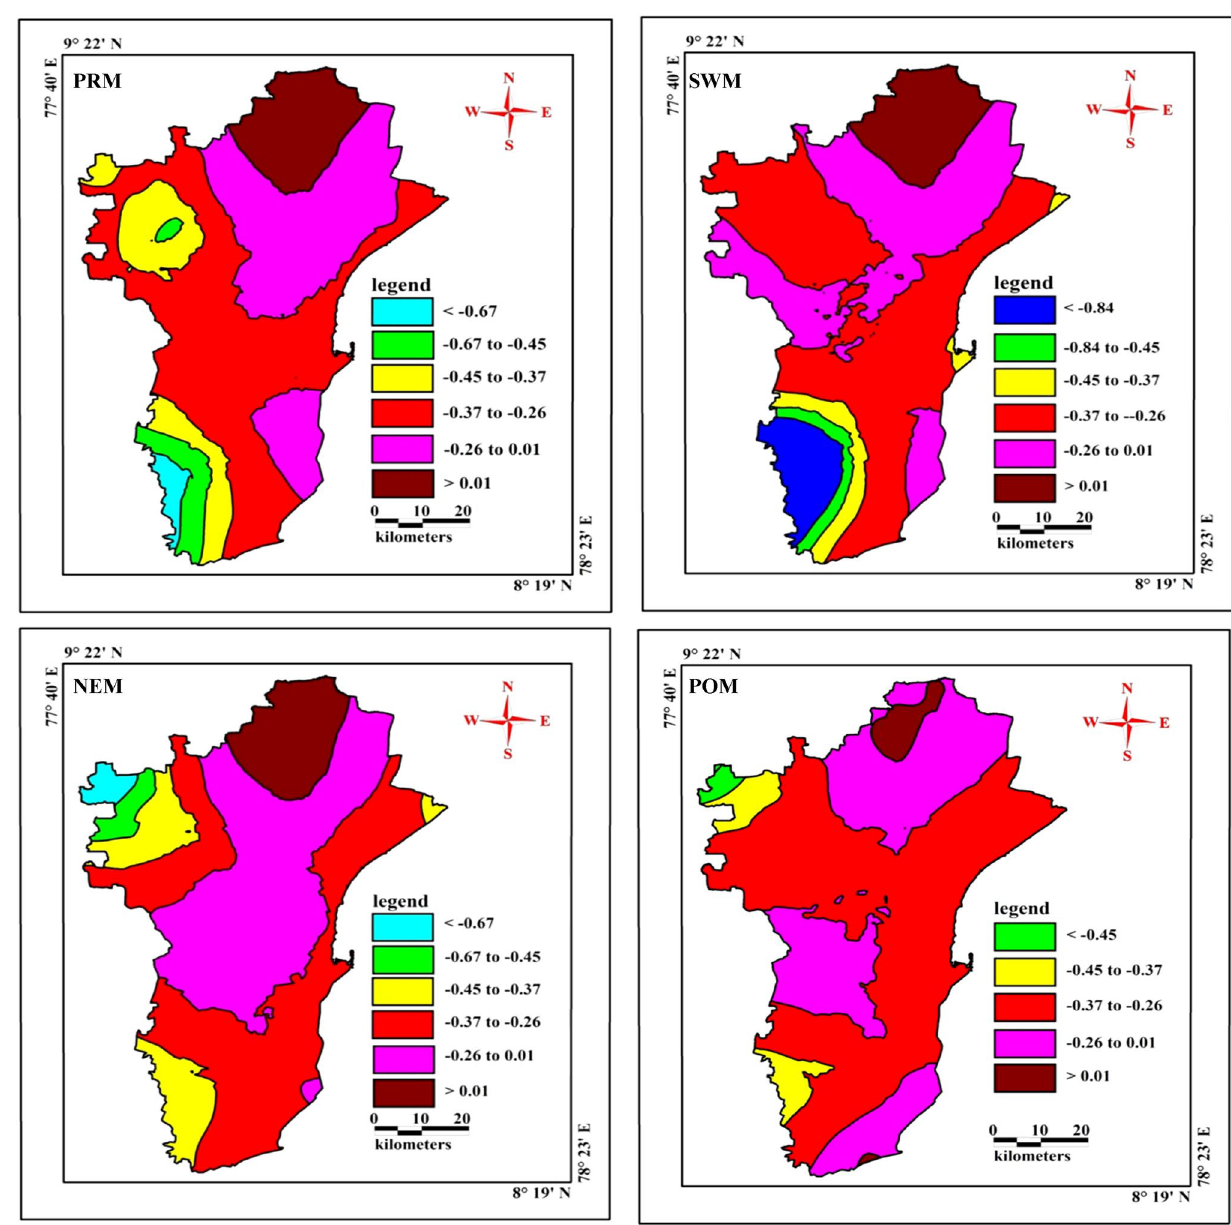
Fig. 12 Spatial distribution of F − and HCO − 3 factor score during different